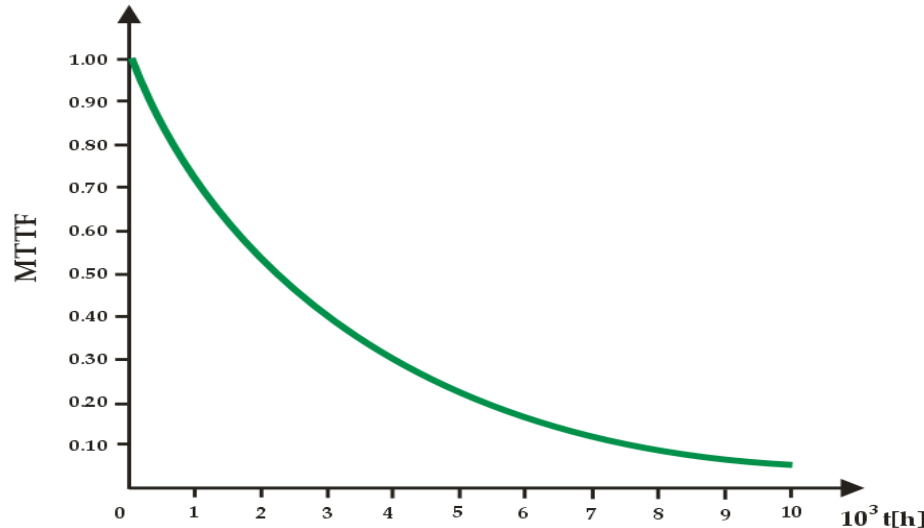
Figure 3. Relationship between MTTF and maintenance M